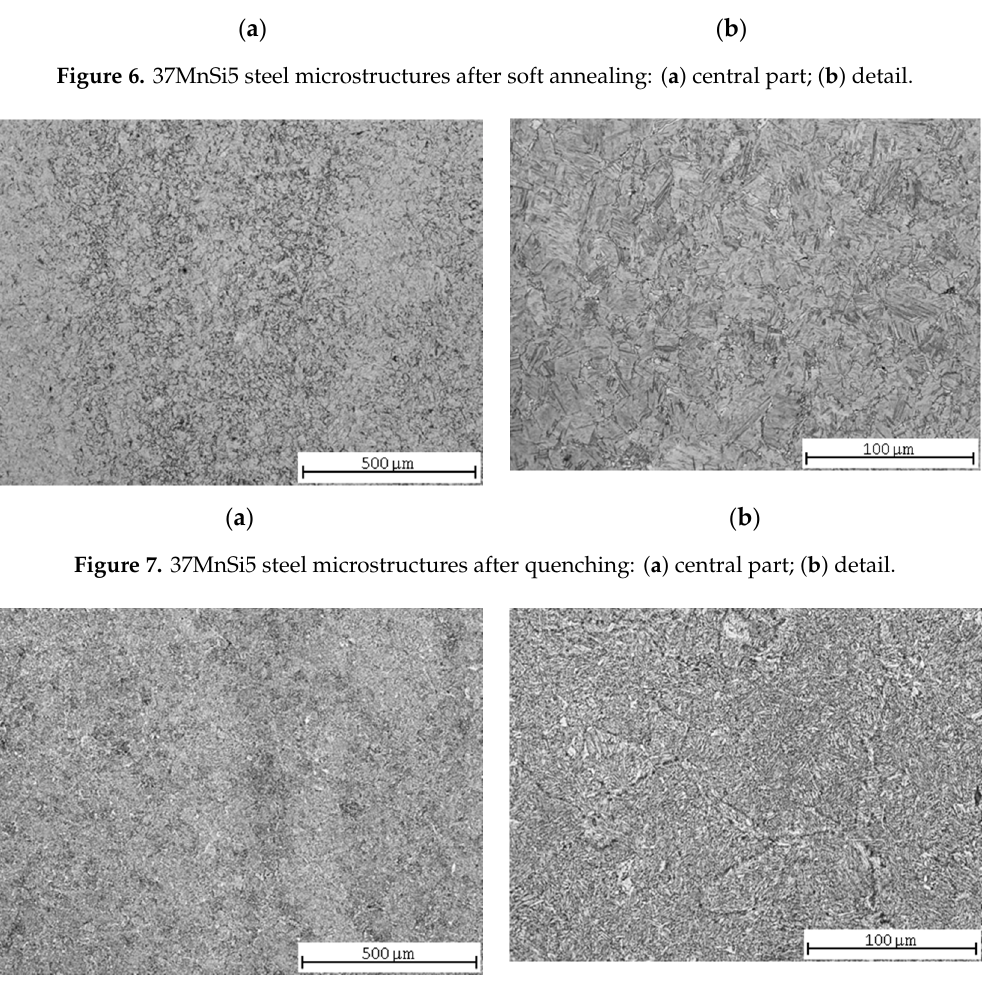
Table 7. Surface roughness characteristics after abrasive waterjet cutting.